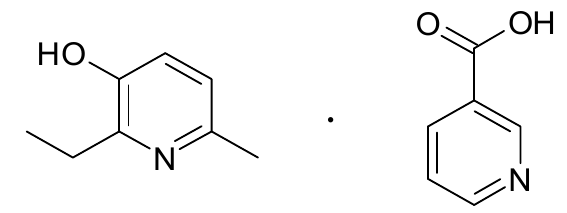
Figure 1. The structure of 2-ethyl-3-hydroxy-6-methylpyridine nicotinate.